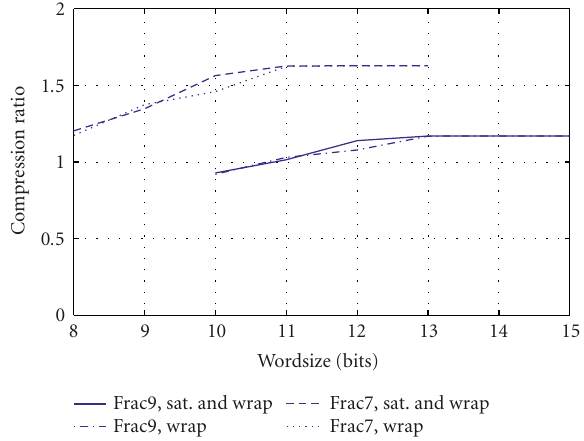
Figure 3: Lossless compression using SPIHT. Wavelet coe ffi cients have 7 bits after the binary point (frac7) or 9bits (frac9); the num- ber of bits before the binary points